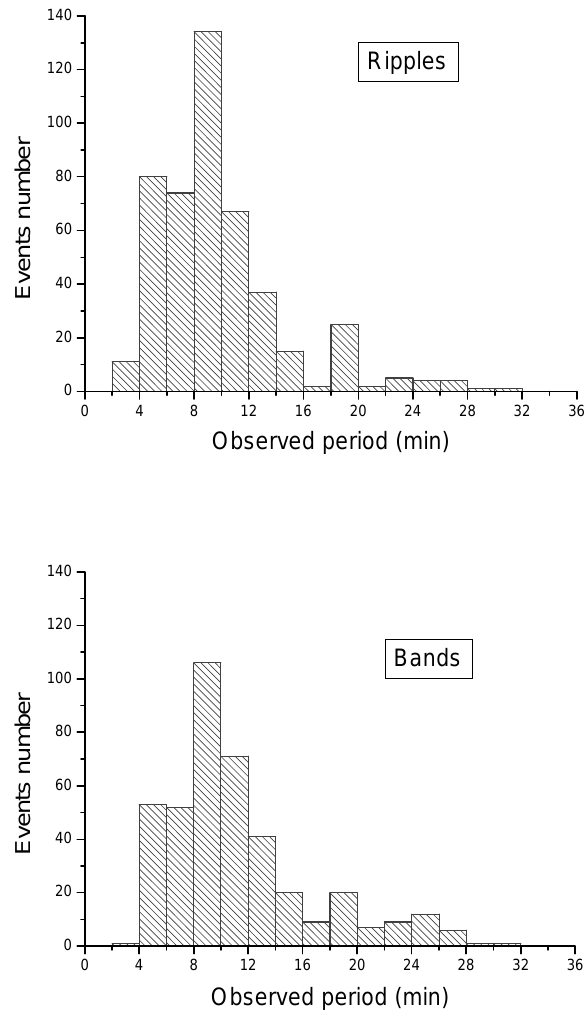
Fig. 4. Histogram of the observed period for bands and ripples binned in 2-min intervals.